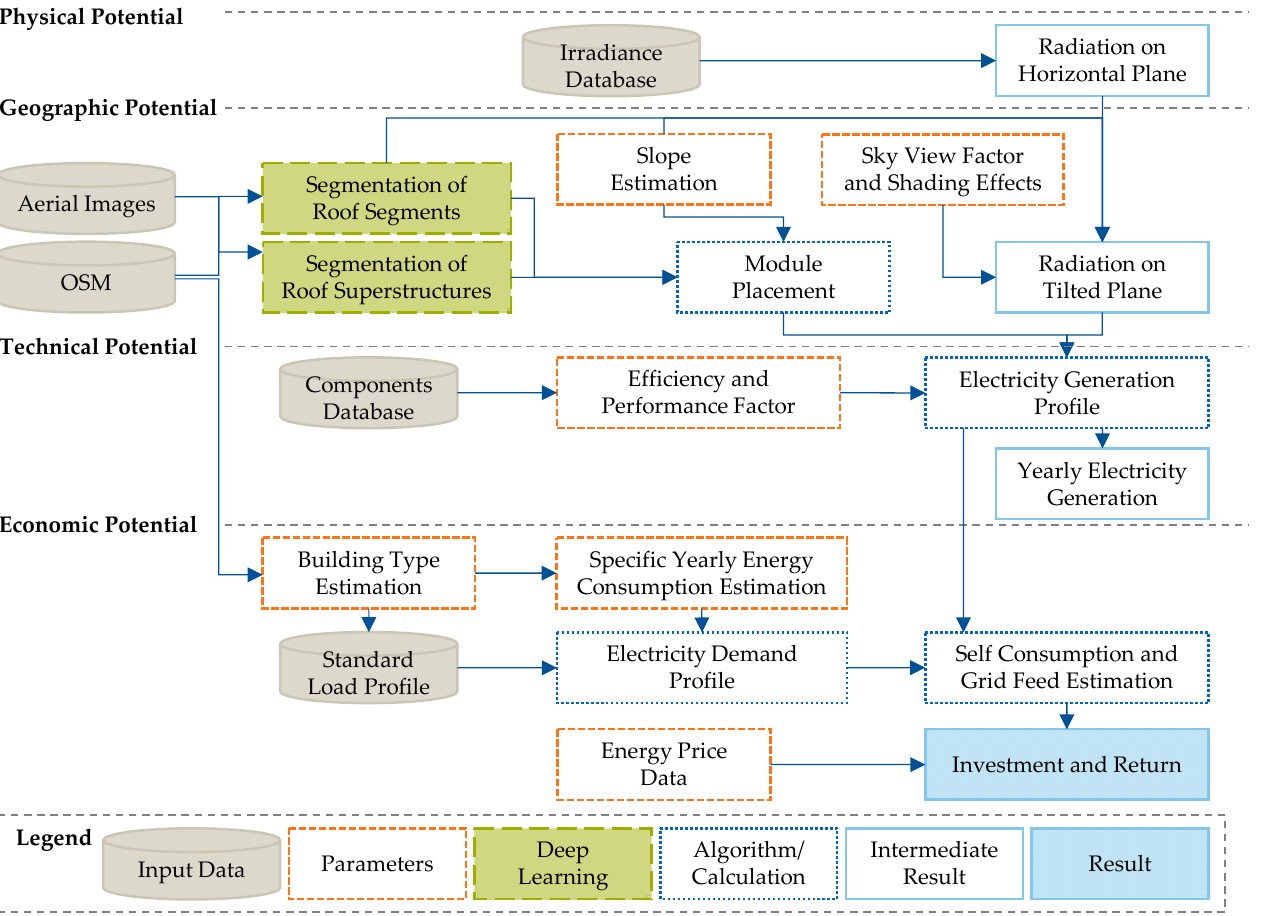
Figure 2. Potential estimation methodology grouped by the four potential types.